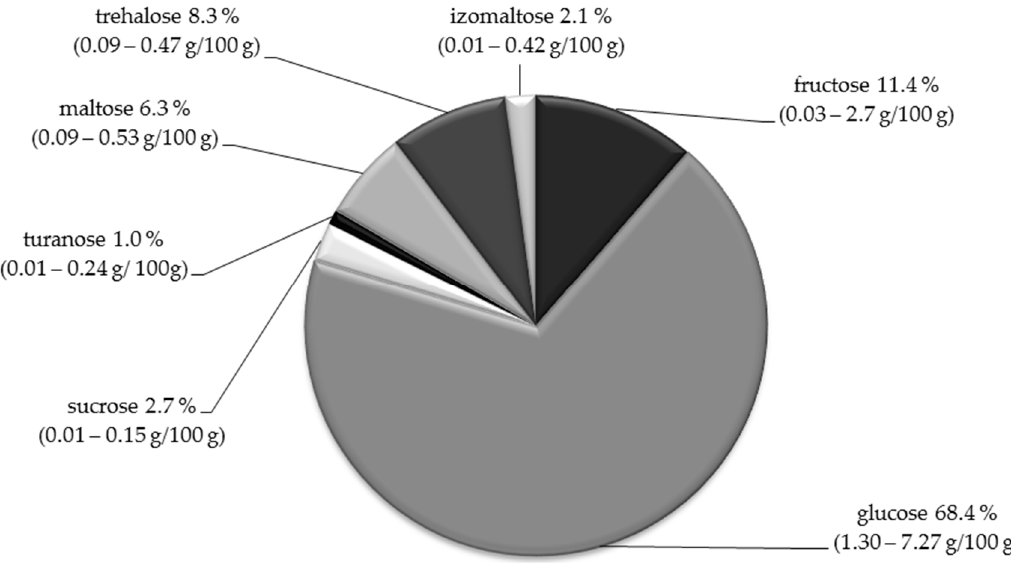
Figure 2. The sugar profile of drone brood homogenate as % share [27]. The range of sugar content in [g/100 g] of the drone brood homogenate is presented in brackets